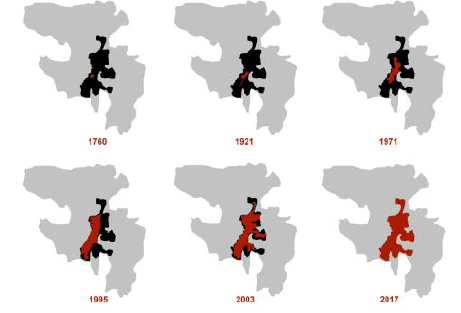
Figure 1. Quito urban growth. Credits: Paola Bracchi.